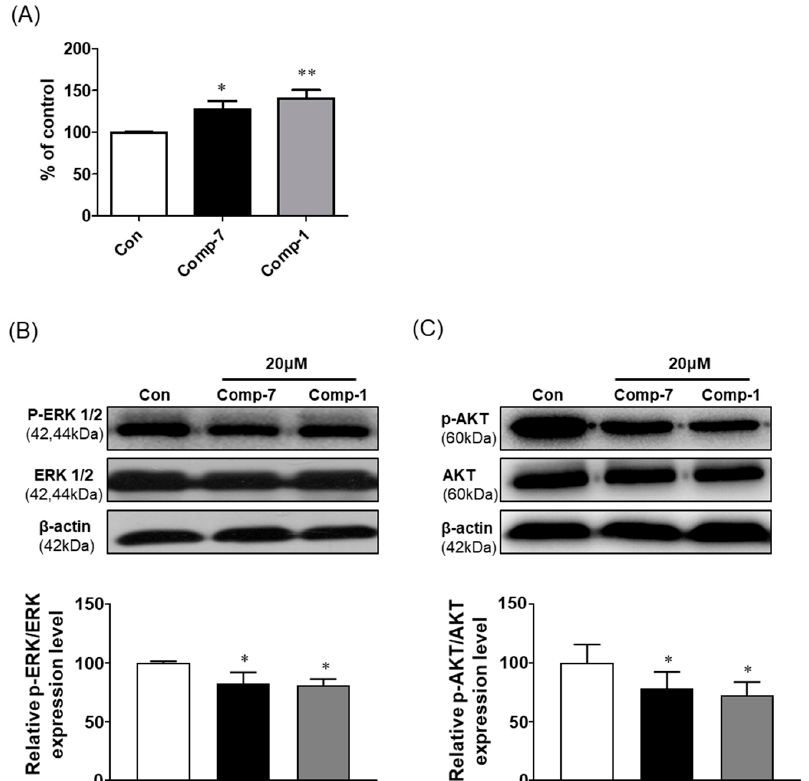
Figure 3. PP2A activity of compound 7 in HT-29 cells. ( A ) PP2A activity was measured in HT-29 cells treated with the 20 µ M of compound 7 and compound 1 (FTY720) for 12 h. ( B , C ) Cells were treated with or without 20 µ M compound 7 and FTY720 for 12 h, protein extracted, separated, and probed with pERK1/2, ERK1/2, pAKT and AKT. The band was analyzed by UVITEC imaging software, and data were plotted as means ± SD for three replicates of the experiments. * p < 0.05, ** p < 0.01 compared with control cells.